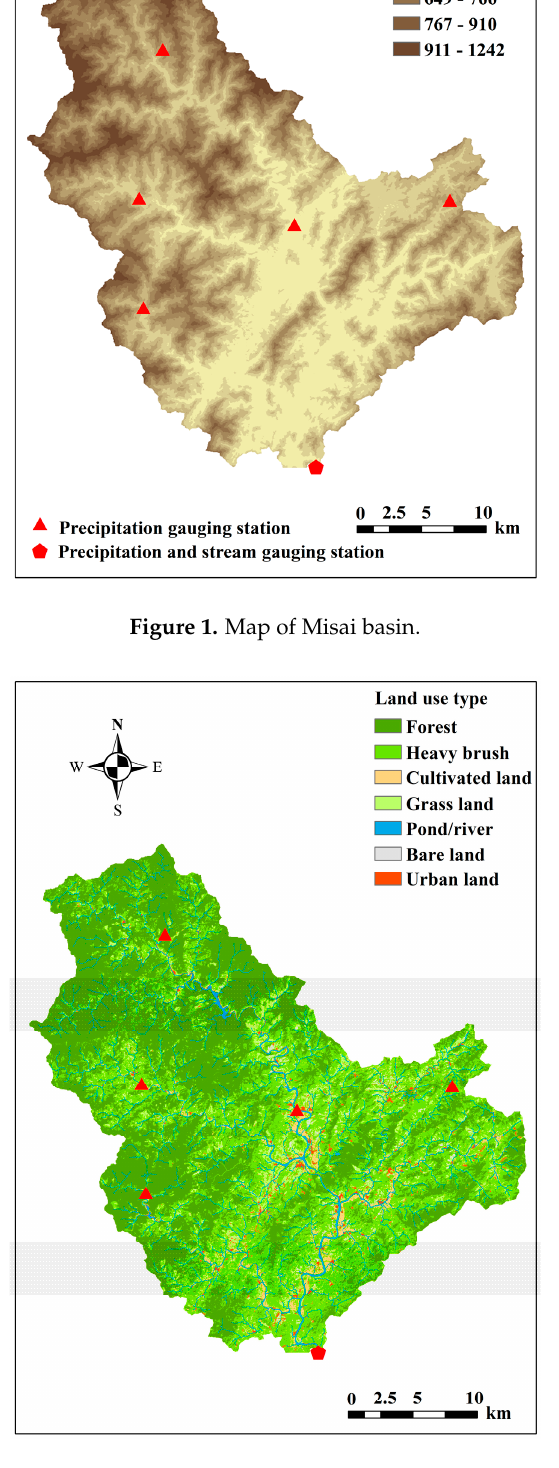
Figure 2. Land use type of Misai basin.